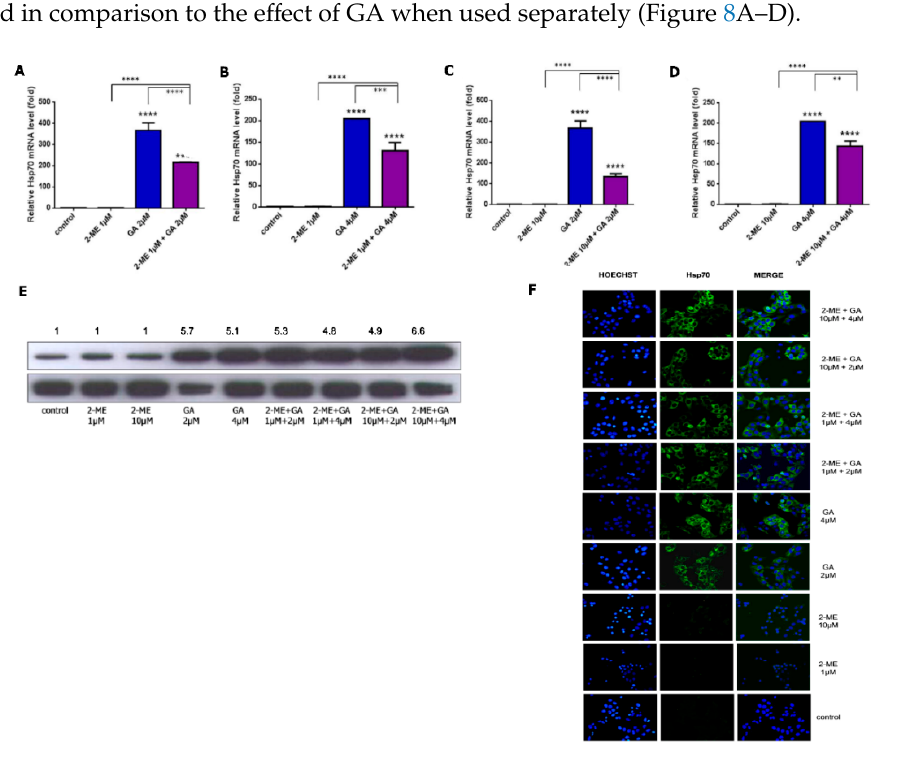
Figure 8. 2-ME has no effect on Hsp70, while GA controls the gene and protein expression of Hsp70 in OS 143B cells. OS 143B cells were treated with either 2-ME (1 μ M or 10 μ M) or GA (2 μ M or 4 μ M) or in a combination of both for 8 h. Next, Hsp70 ( A – D ) gene expression was determined by means of Real Time PCR. Consequently, total pool of Hsp70 protein in OS 143B was determined by western blotting ( E ) and immunofluorescence ( F ), respectively. Cell nuclei were shown in blue, Hsp70 immunoreactivity in green, merged images of both in light green. Original magnification ×40. The representative data from three experiments are presented. Data are presented as the mean ± SE values form at least three independent experiments. The absence of error bar denotes a line thickness greater than the error. Data were analyzed by GraphPad Prism Software version 6.02 performing one way ANOVA analyses followed by Tukey’s multiple comparison test. ** p < 0.001, *** p < 0.0001, **** p < 0.00001 versus control.